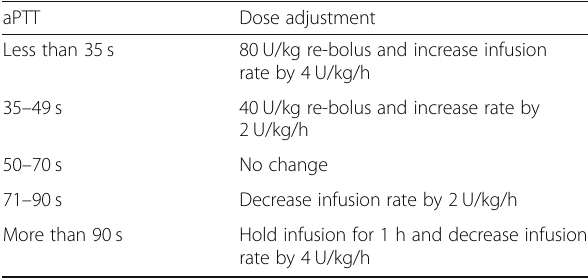
Table 1 Weight-based nomogram for continuous